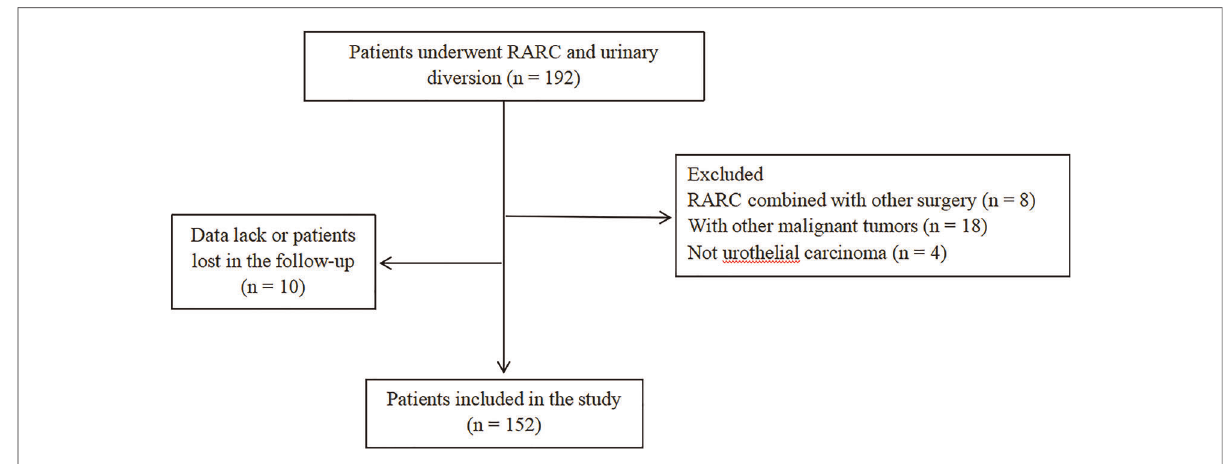
FIGURE 1 The fl ow chart of protocol in the